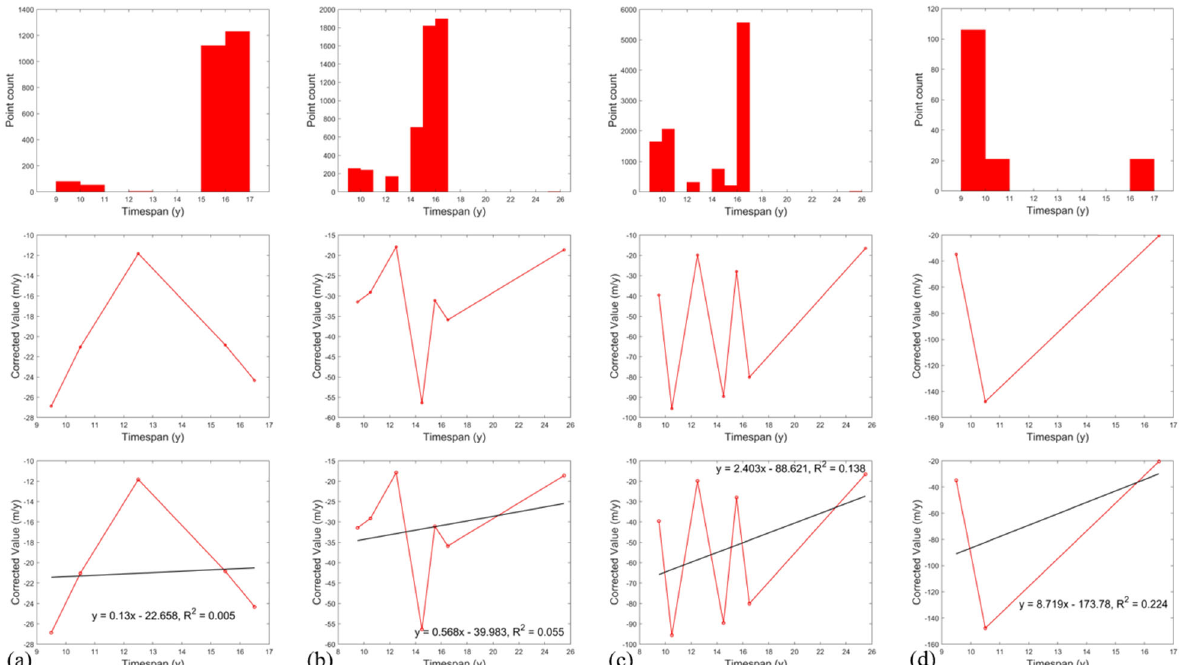
Figure 4 . The relationship between corrected values and Timespan (a) without GL0’25 km buffer and in inland (Sub-region 1), (b) within GL0’25 km buffer and in inland (Sub-region 2), (c) within GL0’25 km buffer and in ice shelf (Sub-region 3), (d) without GL0’25 km buffer and in ice shelf (Sub-region 4).